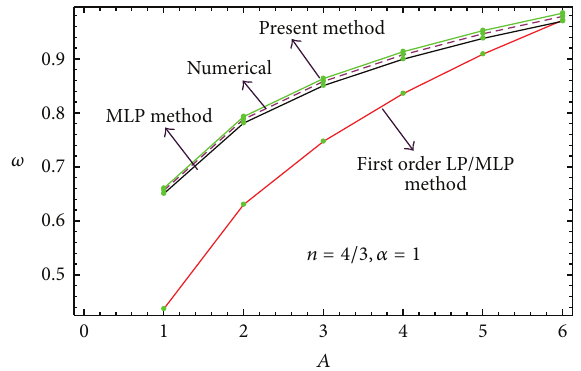
Figure 5: Comparison of various methods for 𝜔 versus 𝐴 of force- deflection oscillator.